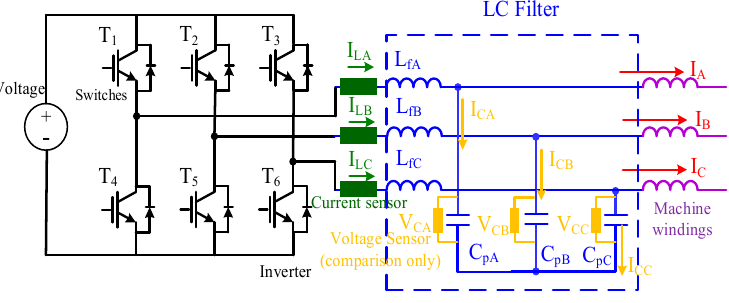
Figure 1. Machine drive with output LC filter. [21].